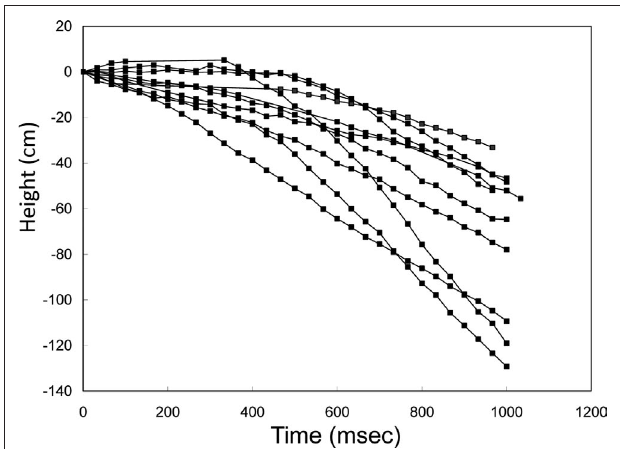
FIgure  | elevation control of a free-flying Mecynorrhina torquata beetle: temporal height-change of a flying beetle (ten flight paths). Alternating positive and negative potential pulse trains at 100 Hz and 2.0 V amplitude to the brain caused the beetle to fly downward. The applied waveform was identical to that in Figure A, but the frequency was different (100 Hz). The median height change was 60 cm (the range was 33–129 cm). See Movie 11 in Supplementary